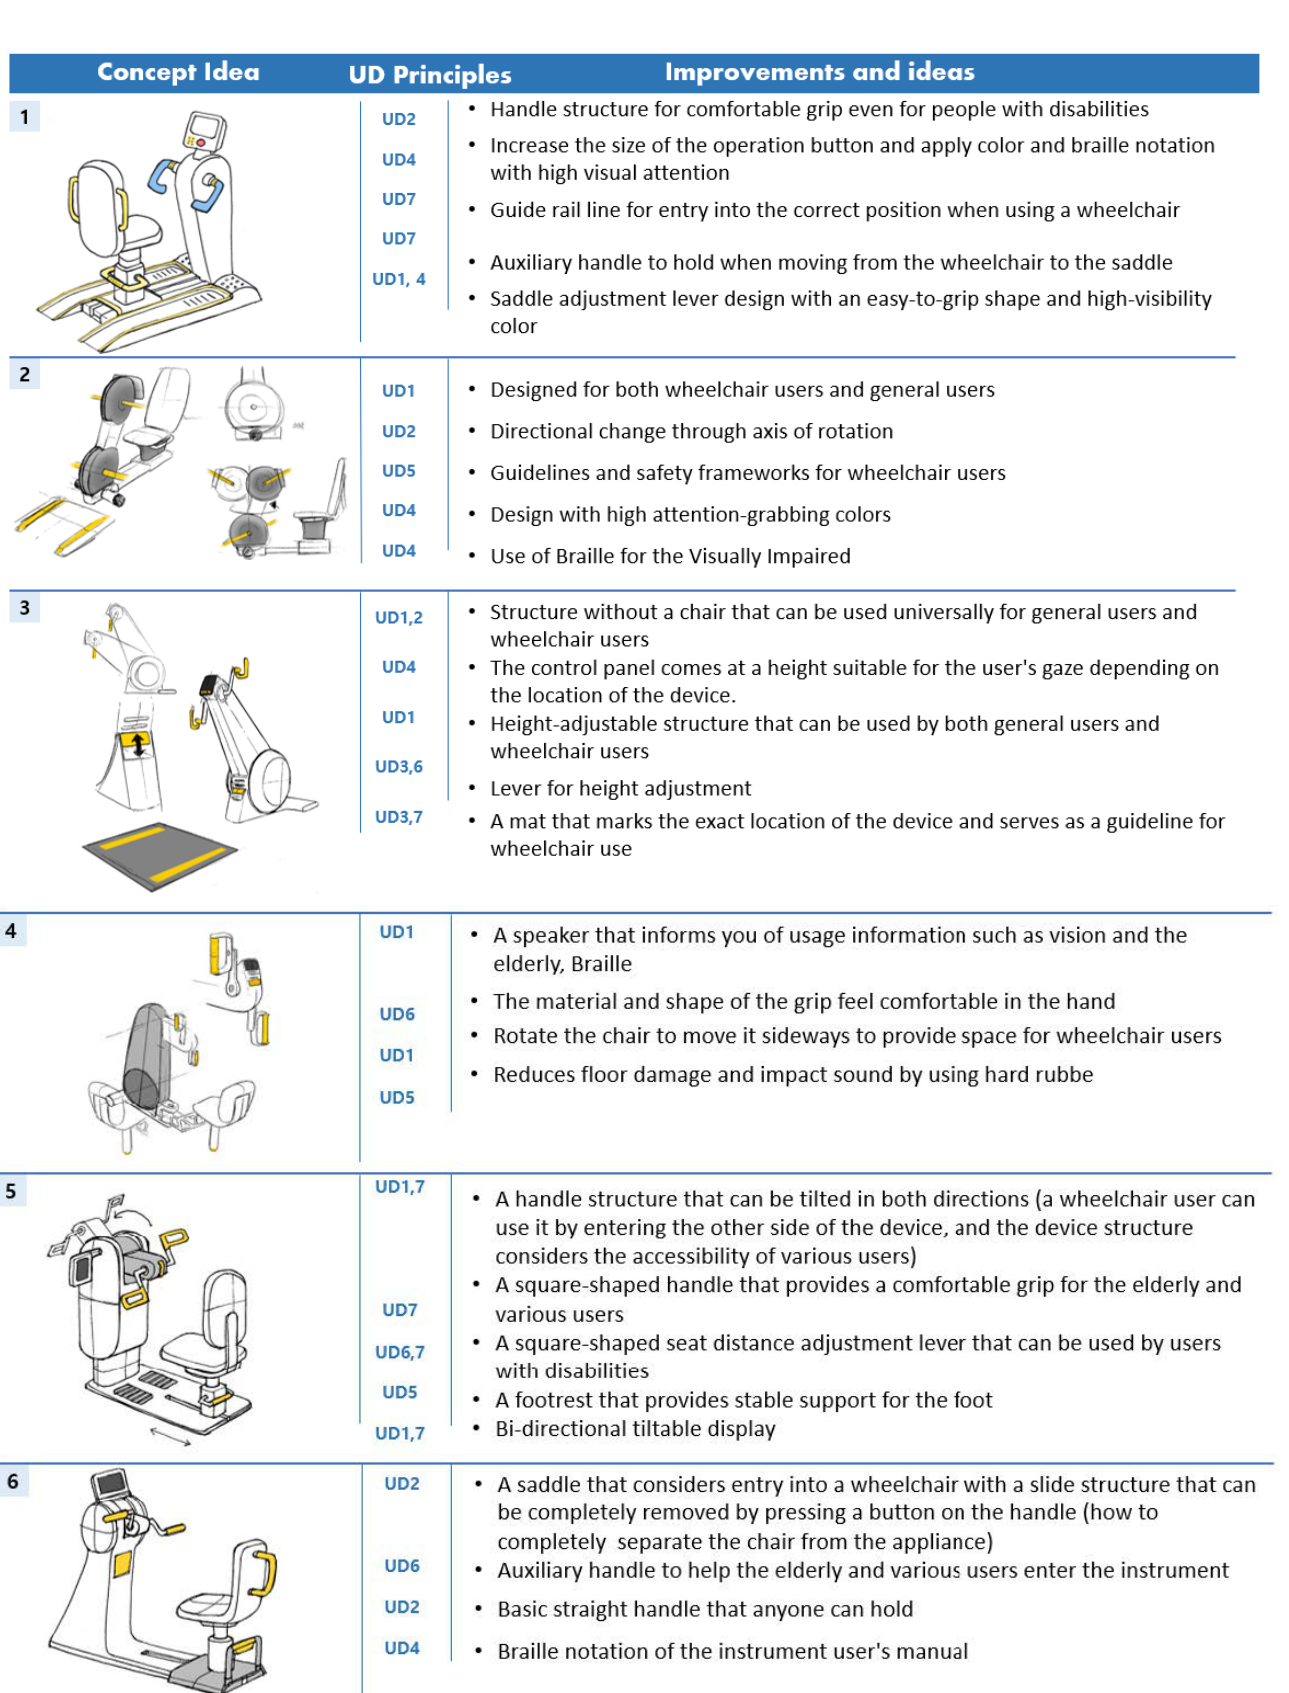
Figure 5. Six types of treadmill concept ideas applied with UD .